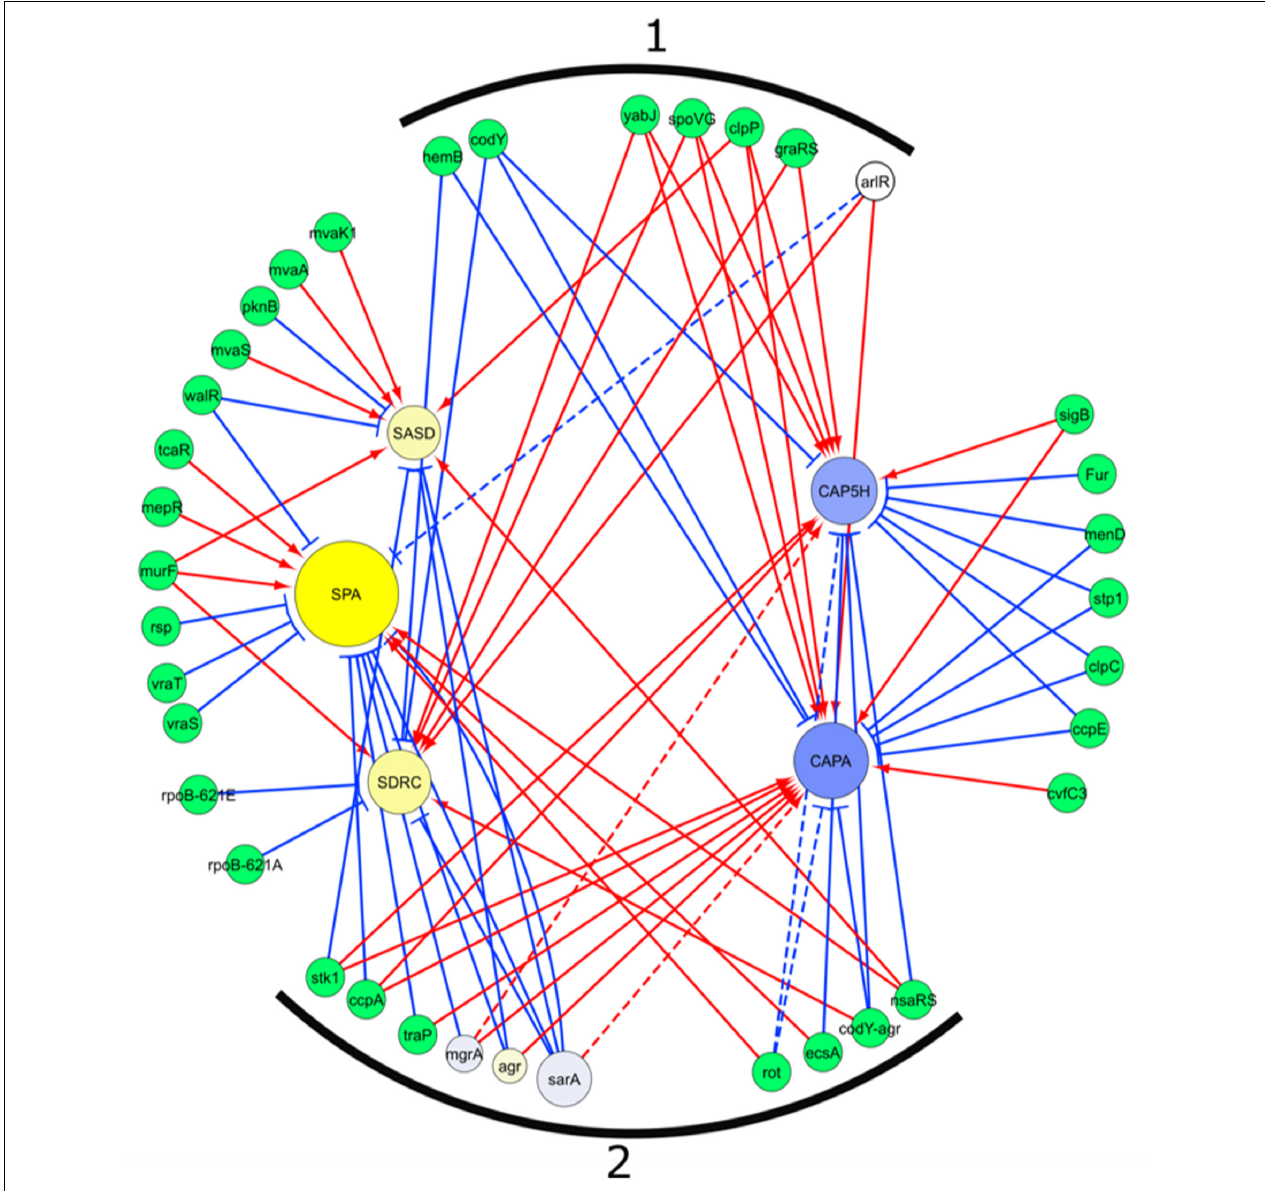
FIGURE 5 | Regulatory network of genes differentially transcribed between SpA + and SpA - . The network was extracted from the SATMD Database. The yellow circles represent genes upregulated in SpA + strains, the blue circles represent the genes upregulated in the SpA - strains. The color intensity represents the magnitude of upregulation in one group of strains or the other. The dimension of the circles is proportional to the -log 10 of the p -value of the ANOVA testing upregulation between SpA + and SpA - strains. Green circles represent genes, or combination of genes, whose deletions influence the transcription of the five genes of interest. The three regulators present in the assays are depicted with the same graphic representation of the differential transcribed genes. Red arrows represent a positive regulation, blue arrows a negative regulation. Dotted lines represent interaction not found in the database, but in the literature. (1) Regulatory genes that influence in both groups of genes transcription, which is not consistent with transcript analysis. (2) Regulatory genes that exert on both groups of genes a regulation consistent with transcript